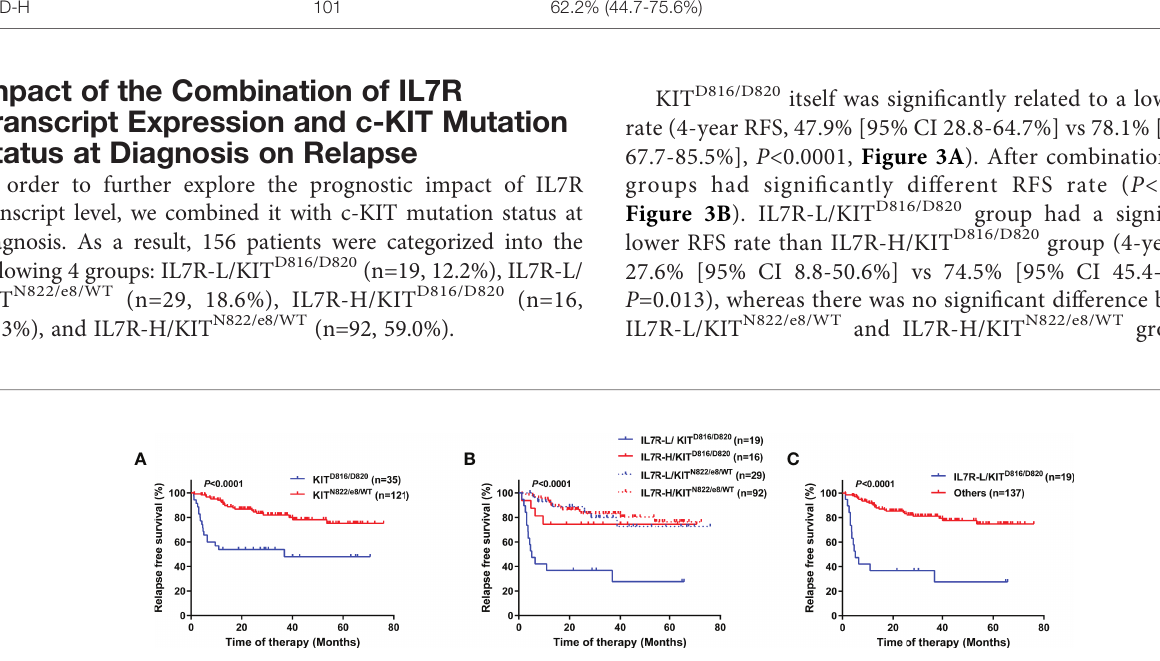
FIGURE 3 | RFS of patients grouped by KIT or the combination of KIT and IL7R using Kaplan – Meier survival analysis (log-rank test). (A) Comparison between patients grouped by KIT mutation status; (B) Comparison between patients categorized into 4 groups; (C) Comparison between patients categorized into 2 groups.